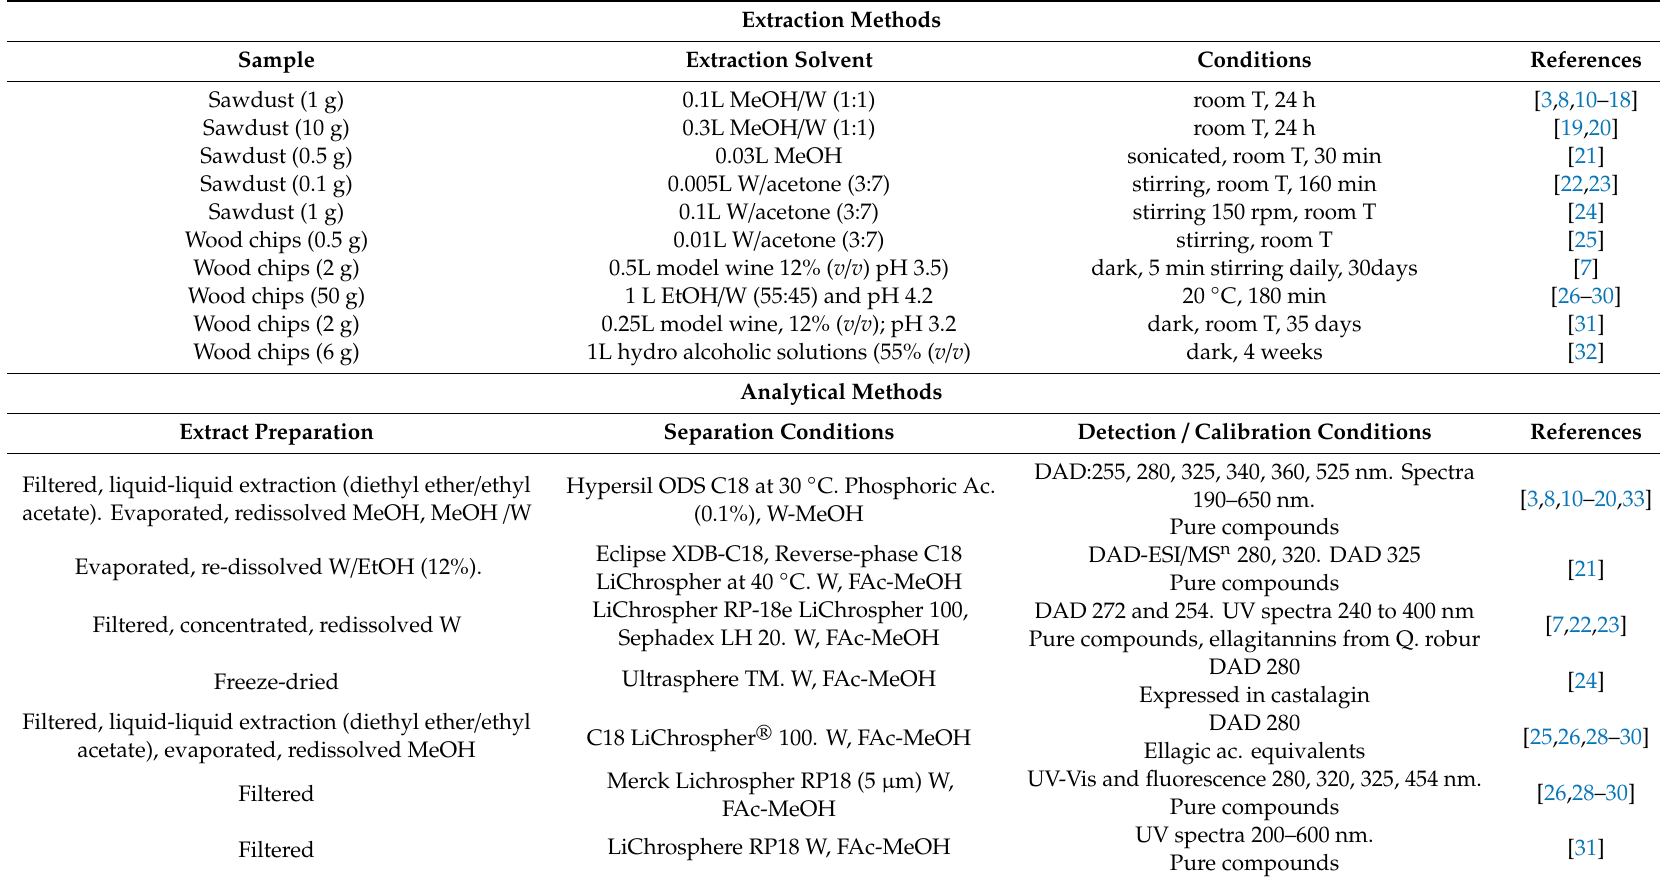
Table 1. Summary of extraction and analysis methods of the compounds studied in di ff erent